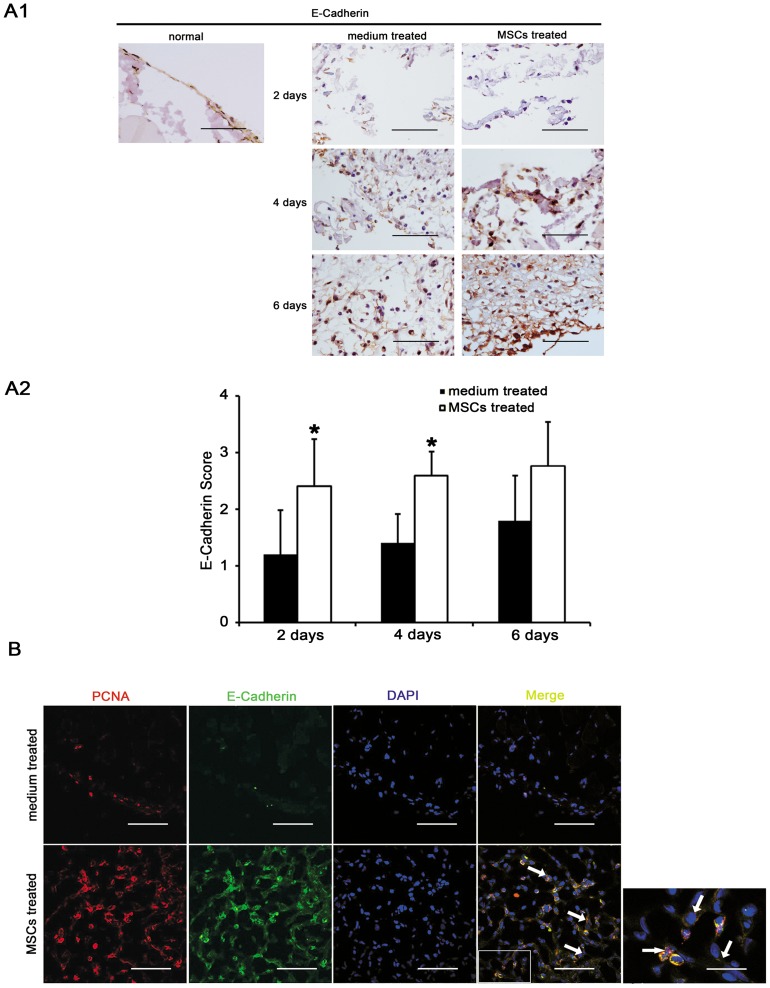
Effects of mesenchymal stem cells (MSCs) on the repair of peritoneal mesothelial cells.(A). Immunohistochemical evaluation of peritoneal mesothelial cells (E-Cadherin) in acute peritoneal adhesions. (A1). The number of mesothelial cells after peritoneal scraping was increased by injecting MSCs. Magnification  = ×400. (A2). The immunohistochemical scores of E-Cadherin days 2, 4 after scraping were increased by injecting MSCs. * compared with medium treated group, p <0.05, n  = 6, respectively. Sections were evaluated from five randomly selected fields under a magnification of ×100 by an independent pathologist. The extent of staining was scored as 0 (0%), 1 (1–20%), 2 (21–50%), 3 (51–80%), and 4 (81–100%), indicating the percentage of positive staining in the adhesion tissue. (B). Immunofluorescence evaluation of injured peritoneum days 4 after scraping using antibodies to E-Cadherin (green) and PCNA (red). The nucleus was counterstained with DAPI (blue). Dual-stained cells (indicated as arrows) were predominantly expressed in the MSCs treated group. Magnification  = ×600 and ×1800, when necessary.